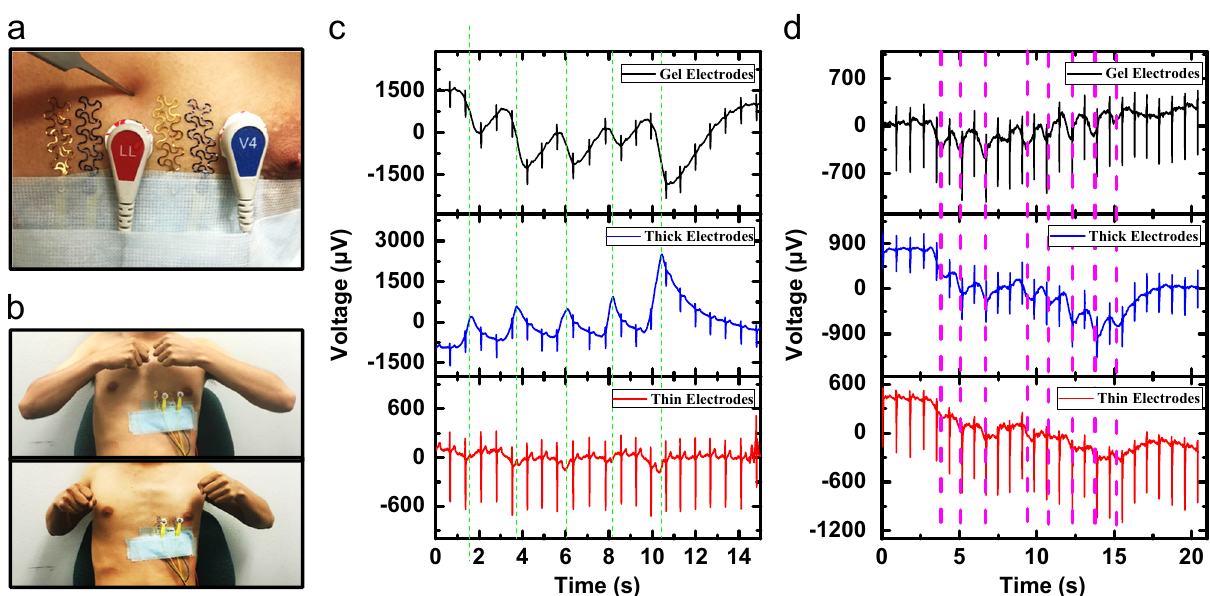
Fig. 4 Investigation of motion artifacts. a Photograph of human chest being poked by tweezer. b Photograph of chest expansion movement. c Synchronously measured ECG under motion demonstrated in ( a ). d Synchronously measured ECG under motion demonstrated in ( b ). Vertical dashed lines indicate the moments of waves, labeled as the P, Q, R, S, T peaks. The gel electrodes, with the lowest interface impedance, yield the highest signal amplitude (black), followed by the ultra-thin electrodes (red). The thick electrodes have the highest interface impedance, as a result, its signal amplitude is the lowest (blue). If we shift all six electrodes about 4 cm lower than their position in Fig. 3b inset, as shown in Fig. 3c inset, we may also capture the respiration by tracking the position of the S waves, as plotted in Fig. S7 and Fig. 3c. The fl uctuation of ECG with respiration can be explained by respiration induced heart-electrode impedance change. During inspiration, lung expansion increases the distance between the heart and the skin and the electrical impedance between the heart and the skin- mounted surface electrodes increases correspondingly, vice